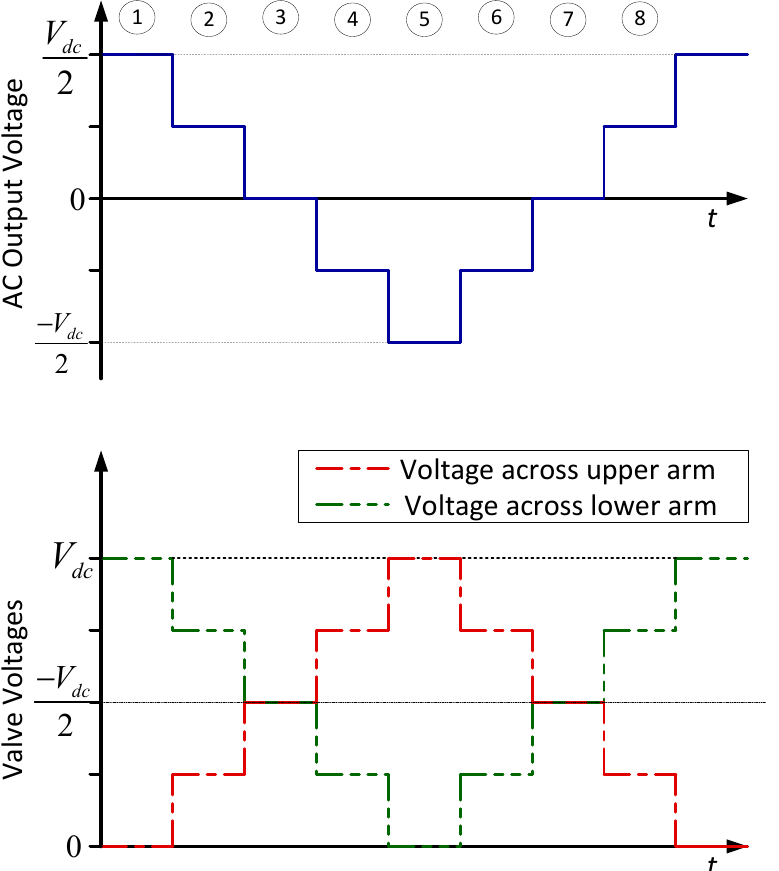
Figure 23. Submodule Operation: ( a ) Circuit and schematic for the capacitor in-line; ( b ) Circuit and The terminal voltage and current of an arm of the MMC converter is compared to that of a two-level schematic for the capacitor by-passed. PWM converter in Figure 26.